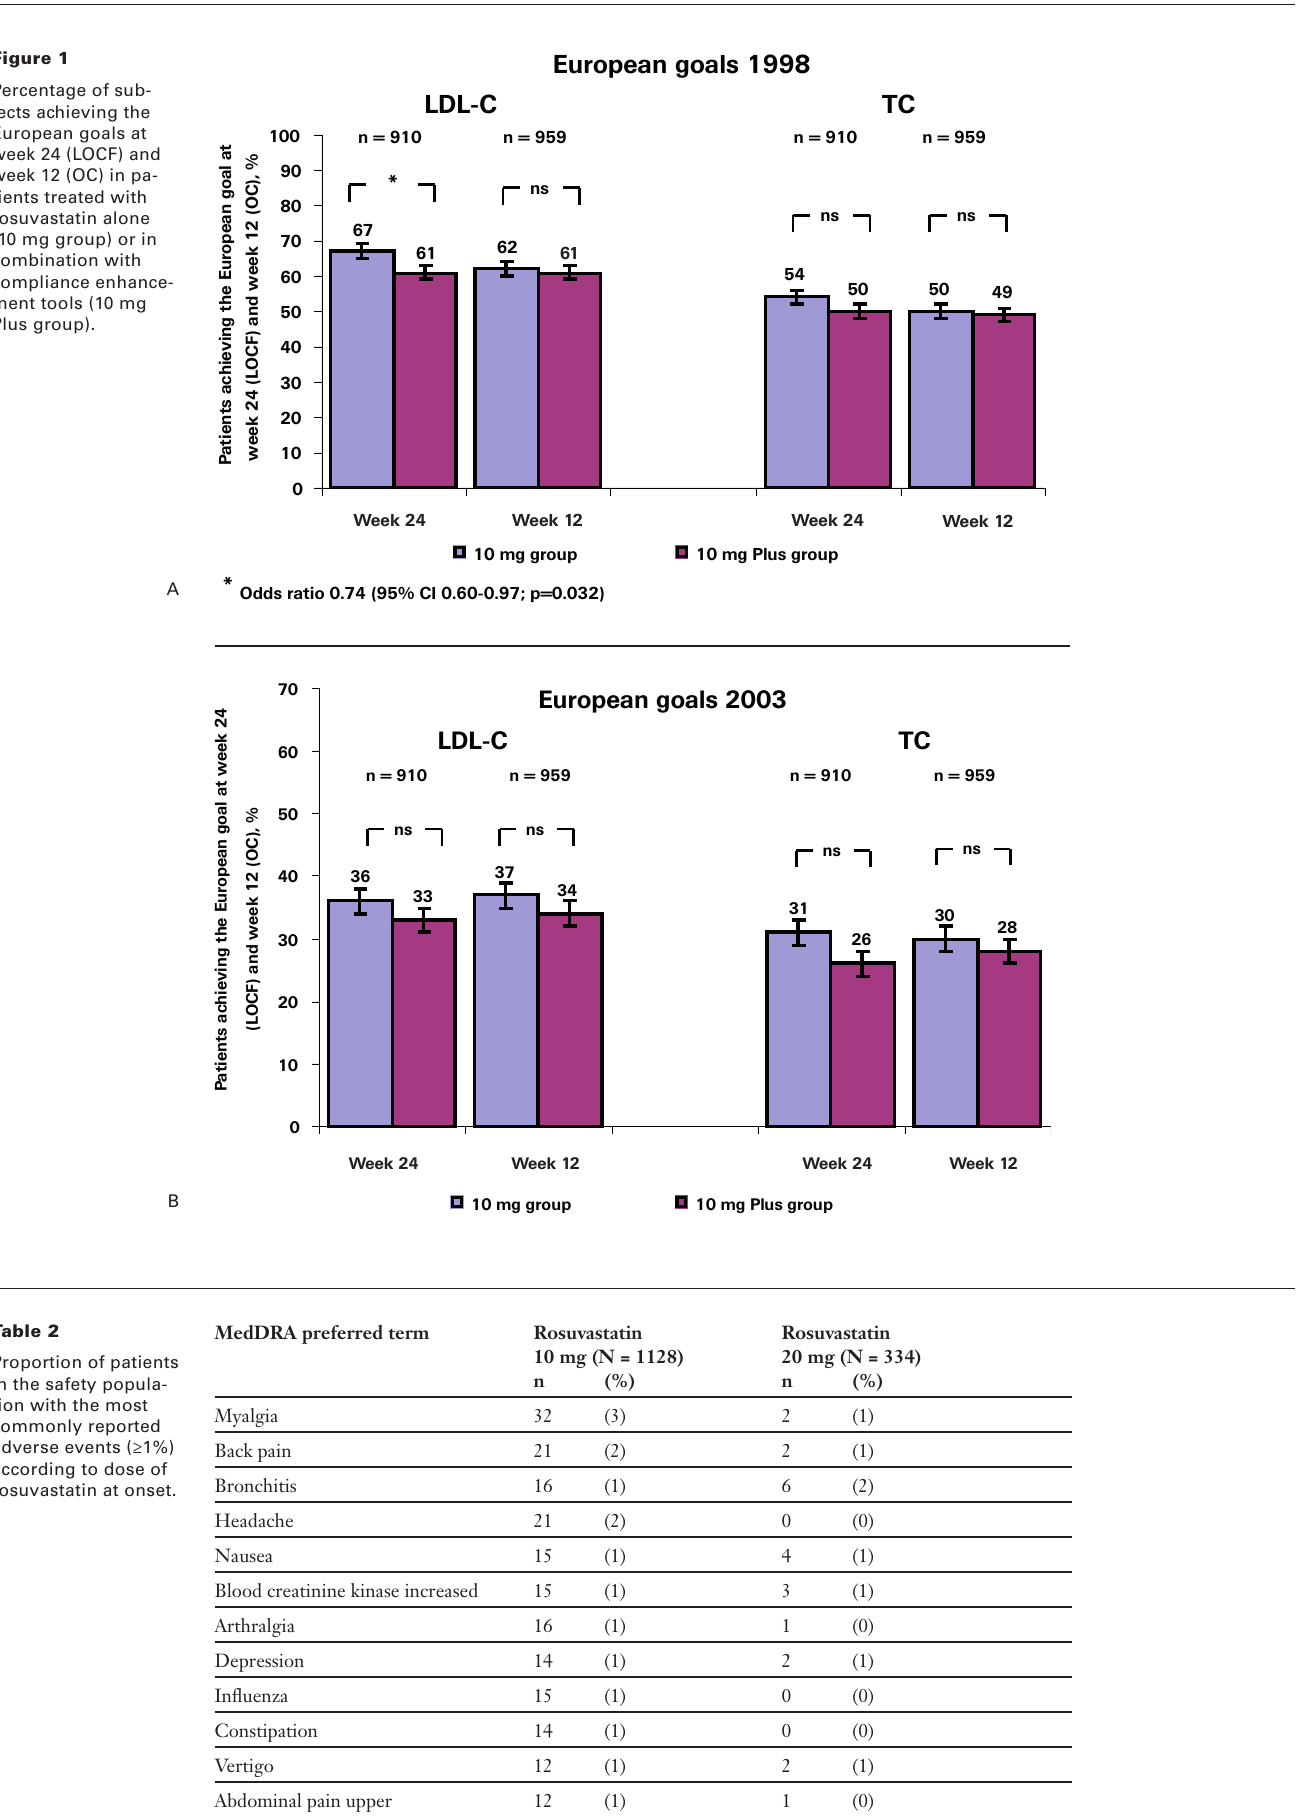
Proportion of patients in the safety popula- tion with the most commonly reported adverse events (≥1%) according to dose of rosuvastatin at